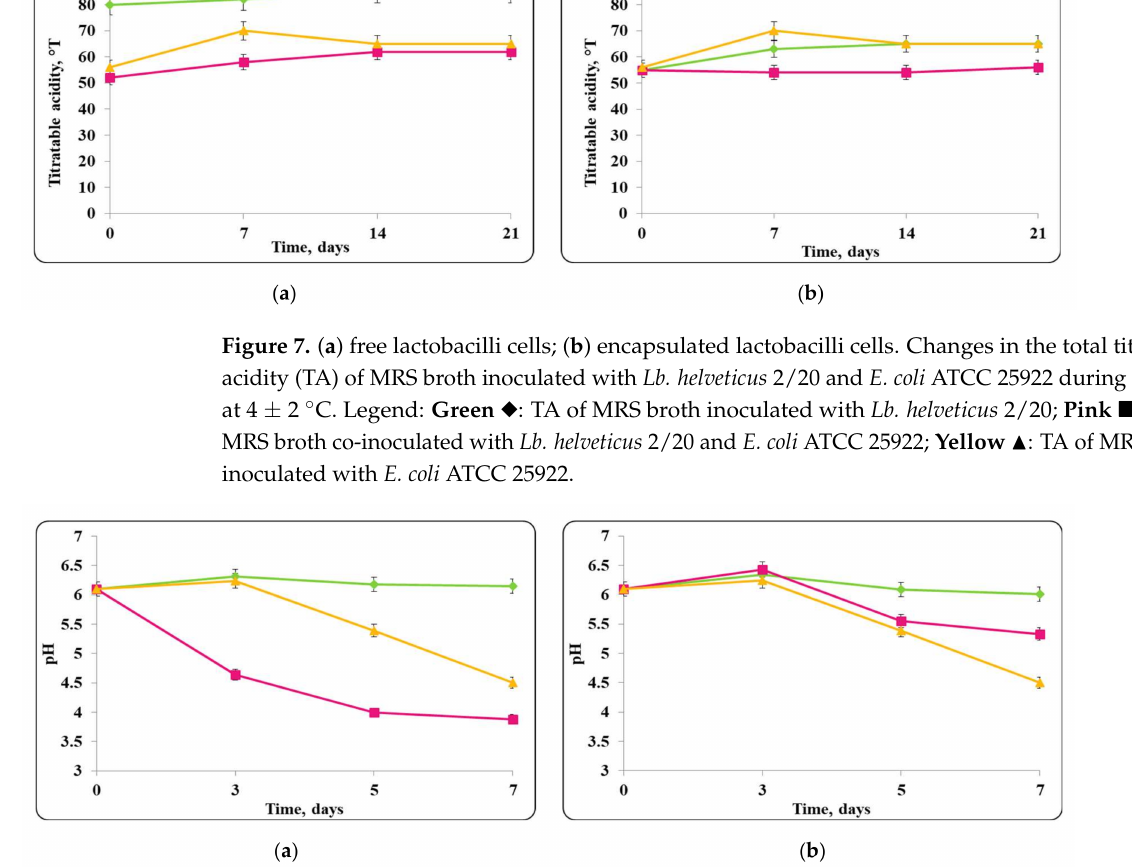
Figure 8. ( a ) free lactobacilli cells; ( b ) encapsulated lactobacilli cells. Changes in the pH of chocolate mousse inoculated with Lb. helveticus 2/20 and E. coli ATCC 25922 during storage at 20 ± 2 ◦ C. Legend: Green (cid:117) : pH of chocolate mousse inoculated with Lb. helveticus 2/20; Pink (cid:4) : pH of chocolate mousse co-inoculated with Lb. helveticus 2/20 and E. coli ATCC 25922; Yellow (cid:78) : pH of chocolate mousse inoculated with E. coli ATCC